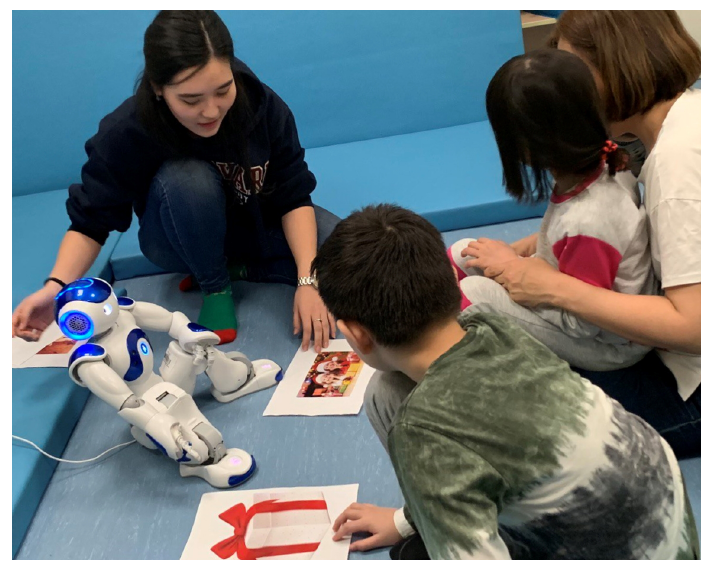
Figure 1. Experimental